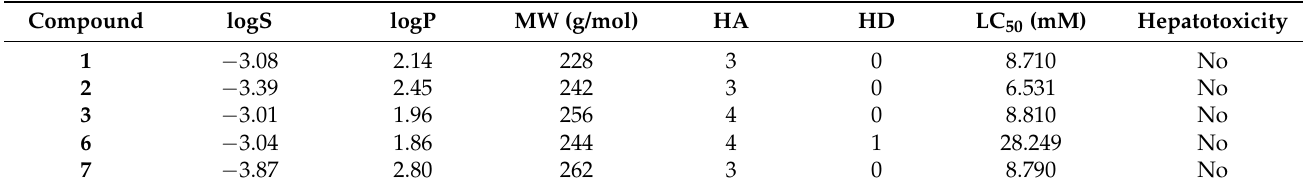
Table 4. The ADMET parameters for compounds 1–3 and 6–7